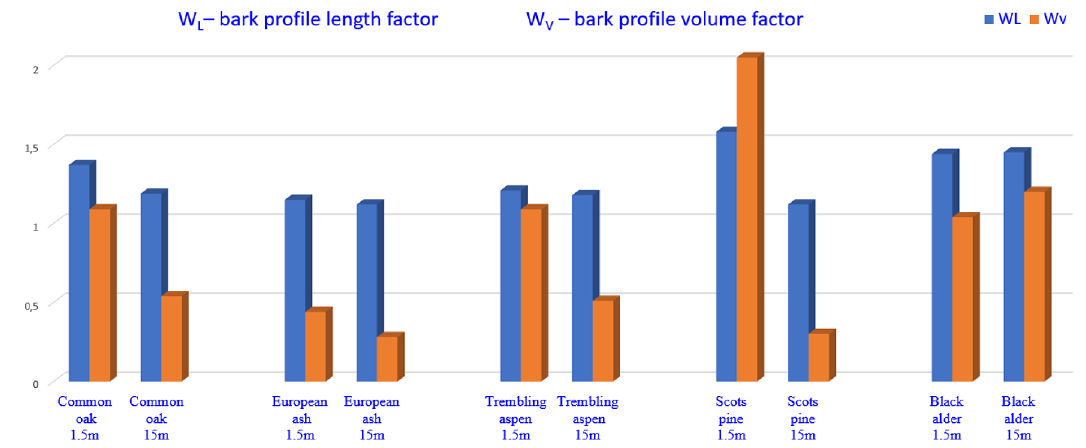
Figure 10. Comparisons of W L and W V coefficients calculated for each bark sample collected at the heights of 1.5 and 15 m for each tree species.